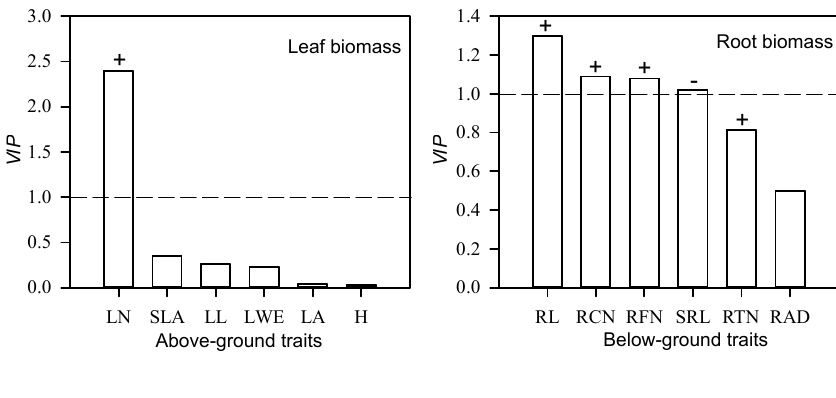
Figure 6 e variable importance projection (VIP) of tillering Stipa breviflora leaf biomass and aboveground functional traits (le), and the variable importance projection (VIP) of tillering S. breviflora root biomass and belowground functional traits (right). “+” indicates that the trait is positively correlated with the biomass ( p < 0.01); “ − ” indicates that the trait is negatively correlated with the corresponding biomass ( p < 0.01). LN – leaf number; SLA – specific leaf area; LL – average leaf length; LWE – individual leaf mass; LA – leaf area; H – average plant height; RL – total root length; RCN – root crossing number; RFN – root furcation number; SRL – specific root length; RTN – root tip number; RAD – root average